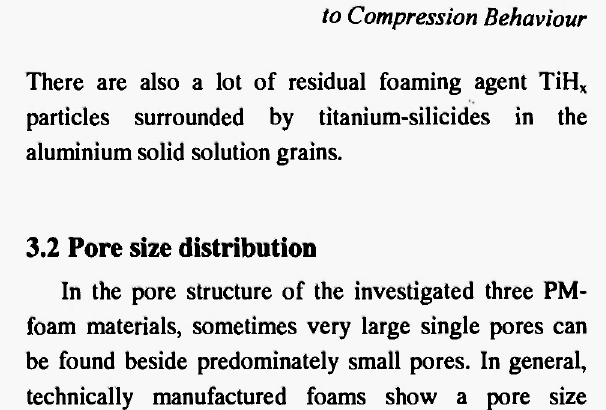
Fig. 1: Examples of pore size distribution estimated from 2D metallographic sections in different depths (alloy